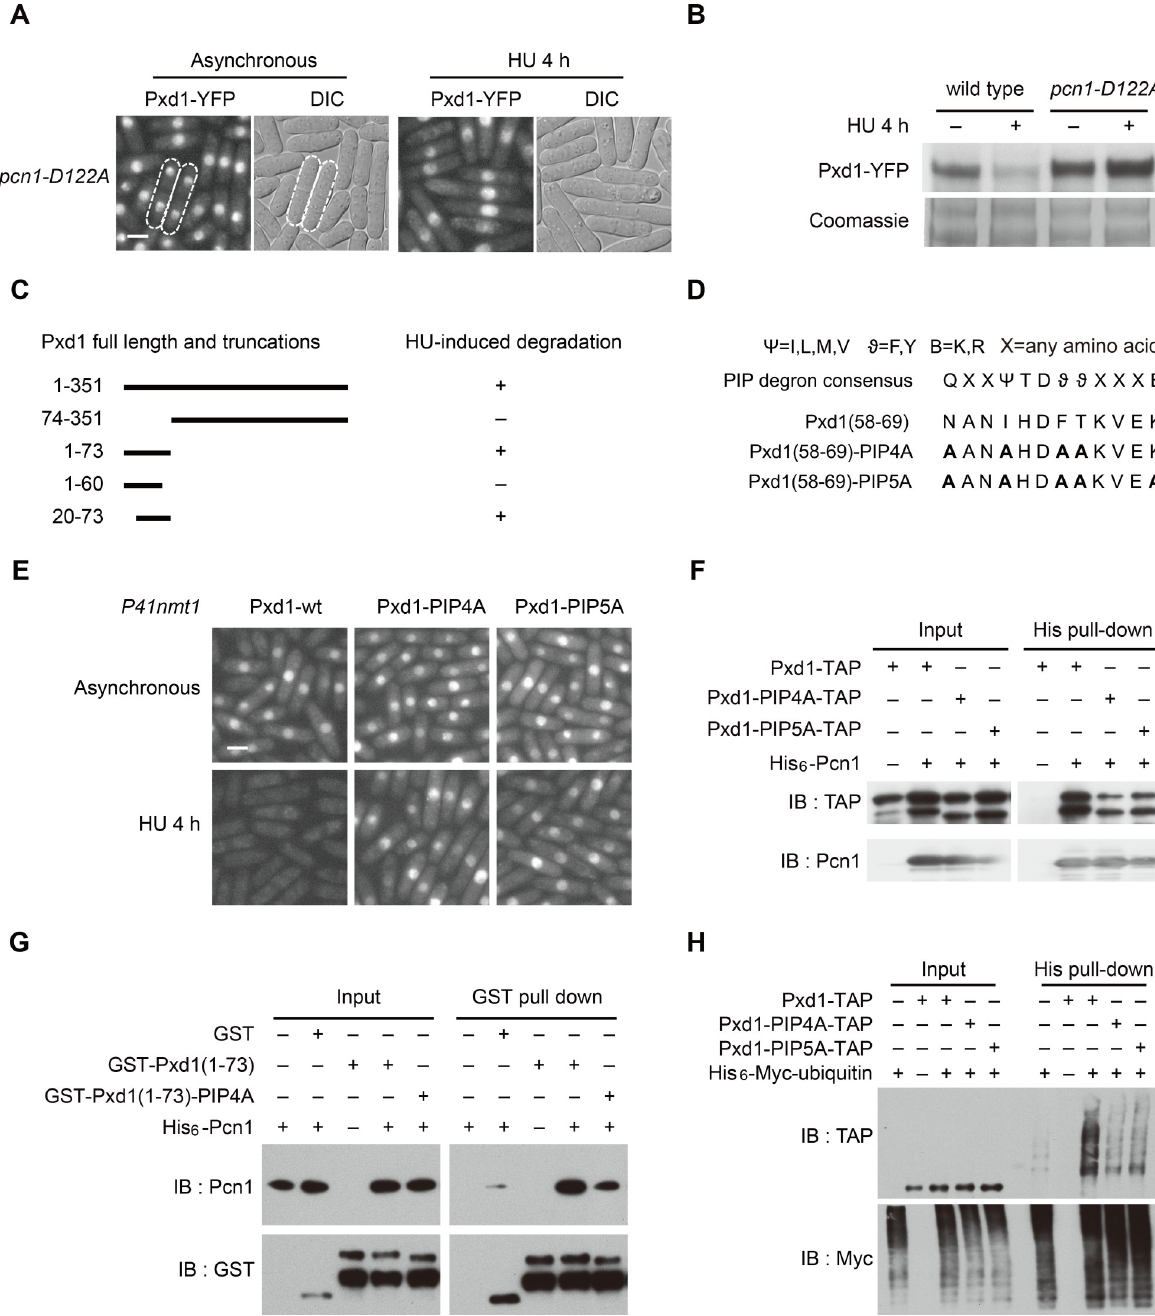
Fig 3. Degradation and ubiquitination of Pxd1 require PCNA and a PIP degron in Pxd1. (A) pcn1-D122A mutation blocked the S-phase reduction of the fluorescence signal of Pxd1-YFP. Cells with septa are marked. See S3A Fig for quantitation. (B) The protein level of Pxd1-YFP was reduced by HU treatment in wild type but not in pcn1-D122A mutant. (C) Summary of the results of a truncation analysis to identify which region of Pxd1 is required for its HU-induced degradation. See S3B Fig for the data. (D) The consensus sequence of the PIP degron and the sequence of the PIP degron we identified in Pxd1. PIP4A and PIP5A are two types of alanine substitution mutations we introduced into the PIP degron of Pxd1. (E) PIP4A and PIP5A mutations abolished the HU-induced reduction of the fluorescence signal of GFP-tagged Pxd1. Pxd1 was expressed from the exogenous P41nmt1 promoter. (F) PIP4A and PIP5A mutations diminished the interaction between Pxd1 and Pcn1. TAP-tagged Pxd1 and His 6 -tagged Pcn1 were expressed from the Pnmt1 promoter. His 6 -Pcn1 was pulled down using Ni-NTA beads. Pcn1 was detected by a PCNA antibody, and Pxd1 was detected by PAP. (G) PIP4A mutations diminished the in vitro interaction between recombinant Pxd1(1–73) and Pcn1. (H) PIP4A and PIP5A mutations diminished the ubiquitination of Pxd1. Enrichment of ubiquitinated proteins was performed as in Fig 2D. Bars, 3 μ m.